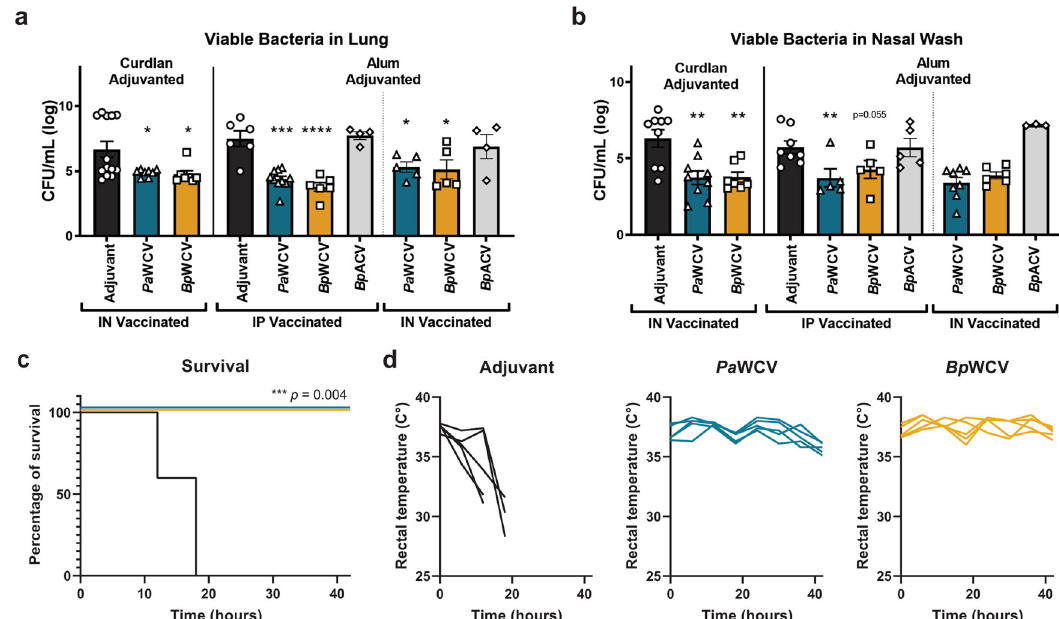
Fig. 2 B. pertussis whole cell vaccination protects outbred and inbred mice against P. aeruginosa acute pneumonia and sepsis. Bacterial burden in the lung ( a ) and the nasal wash ( b ) of mice were vaccinated with Pa -WCV, Bp -WCV and adjuvant alone as control sixteen hours post challenge in a murine model of pneumonia in outbred CD-1 mice. Each dot represents an individual mouse, and error bars represent standard error of the mean. Experiments in a and b were performed with n = 4 – 13 mice/group. Experiments in c and d included n = 5 mice/group. The asterisks represent statistical signi fi cance determined by ANOVA with a Tukey multiple comparison post-test: * p ≤ 0.05, ** p ≤ 0.01, *** p < 0.001, **** p < 0.0001. Survival ( c ) and body temperature ( d ) over time of CD-1 mice vaccinated with Pa -WCV, Bp -WCV and the alum adjuvant alone as control in a lethal model of sepsis. Log-rank Mantel-Cox analysis of